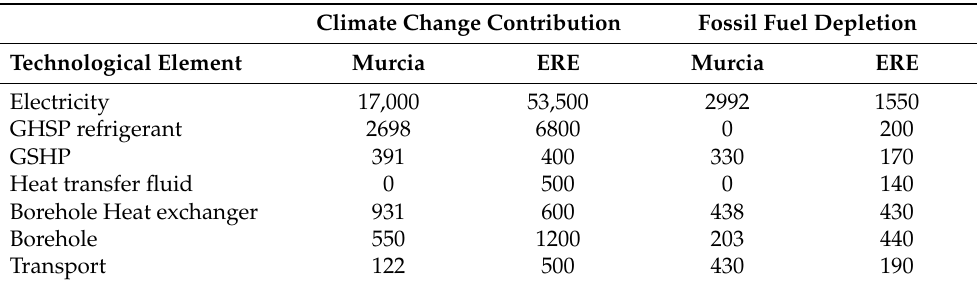
Figure 5. Relative contributions of the technological elements to the contribution to climate change ( above ) and fossil fuel depletion ( down ) ReCiPe category of a GSHP system in Europe (ERE) and Murcia region. Table 4. The total contribution of CO 2 emissions of the technological component in LCA for the Murcia region and Europe (ERE) (CO 2